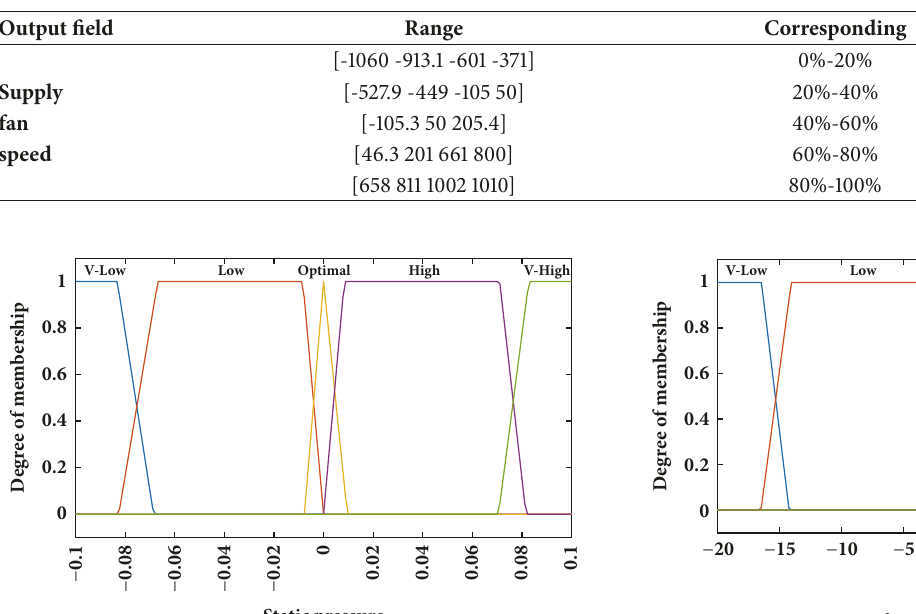
Figure 14: MFs of CO 2 level difference ( Δ CO 2 ).